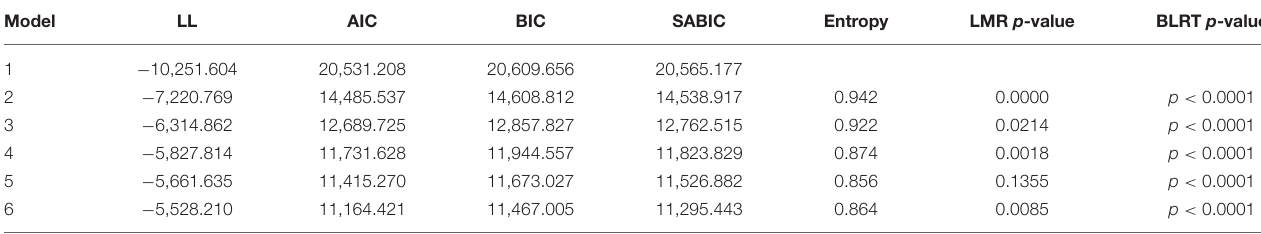
TABLE 2 | Model fit summary of the latent profile analysis of the foster care, clinical, and general population youth samples. Model